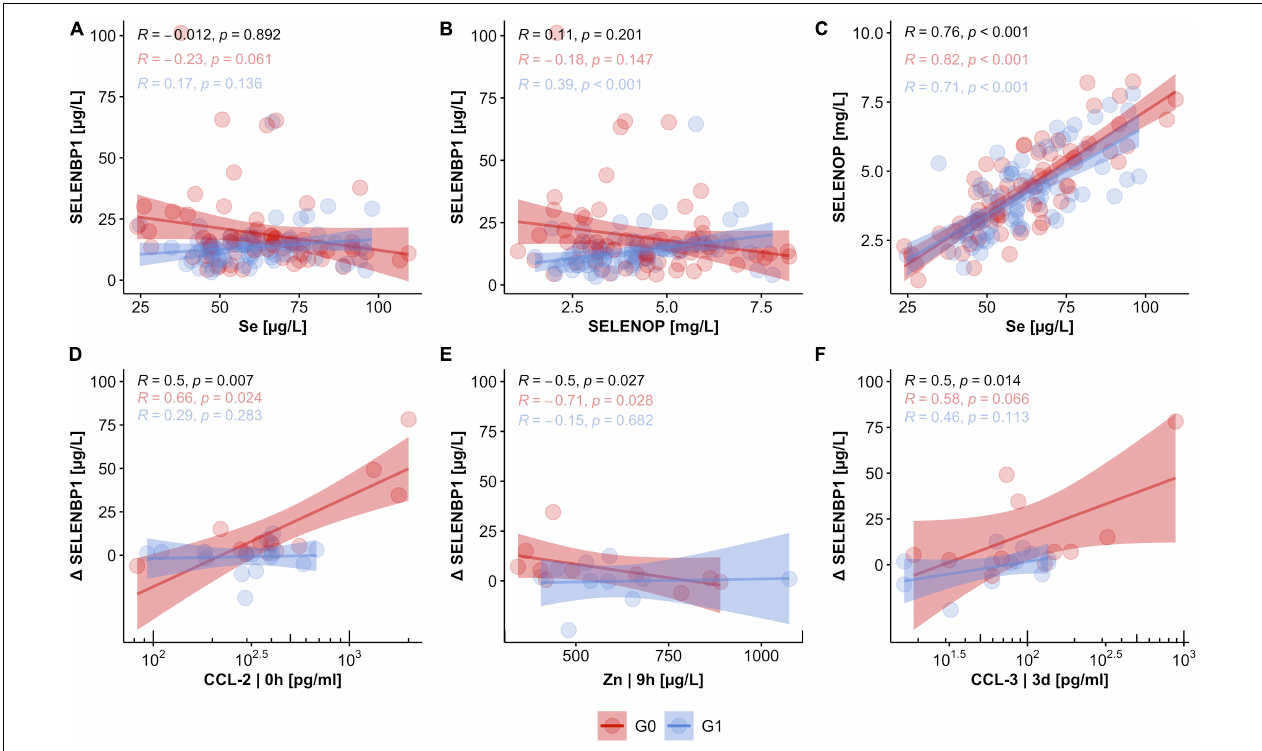
FIGURE 5 | Relation of circulating SELENBP1 concentrations to established biomarkers of Se status and potential covariates in TSCI. The concentrations of circulating SELENBP1 were not associated with either serum Se levels (A) or SELENOP concentrations (B) , whereas a tight linear correlation between total serum Se and SELENOP concentrations was given (C) . Concentrations of CCL-2, Zn, and CCL-3 were strongly associated with declining serum SELENBP1 in patients without neurological improvement after 3 months. In contrast, no significant coherence of CCL-2, Zn, and CCL-3 concentrations with SELENBP1 were observed in the group of patients with neurological improvement in G1 (D–F) . Correlation analysis by Pearson, R indicates the correlation coefficient, and p indicates significance, provided on top of the graphics for all samples (black), and the two groups of patients separately (G0; red, G1;